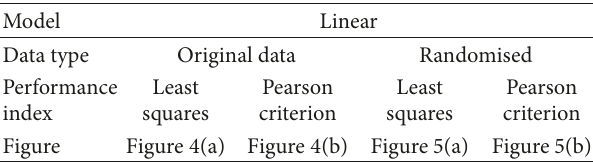
Table 1: Nested factorial design for linear model: field pH versus lab pH in 1:5 water (pH F versus pH w ).